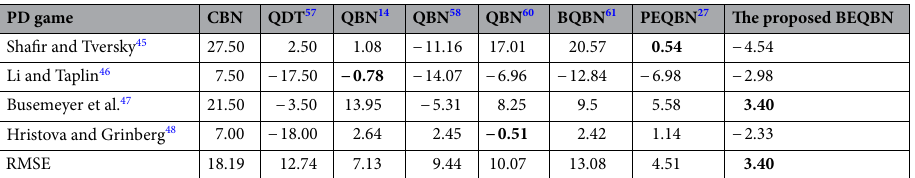
Table 4. Errors between predicted probability and empirical results for Pr ( B = defect ) in the PD game under uncertainty. Predicted values are obtained by applying the BEQBN model CBN, QDT 57 , QBN 14 , QBN 58 , QBN 60 , BQBN 61 , and QBN 27 to the PD game. Significant values are in